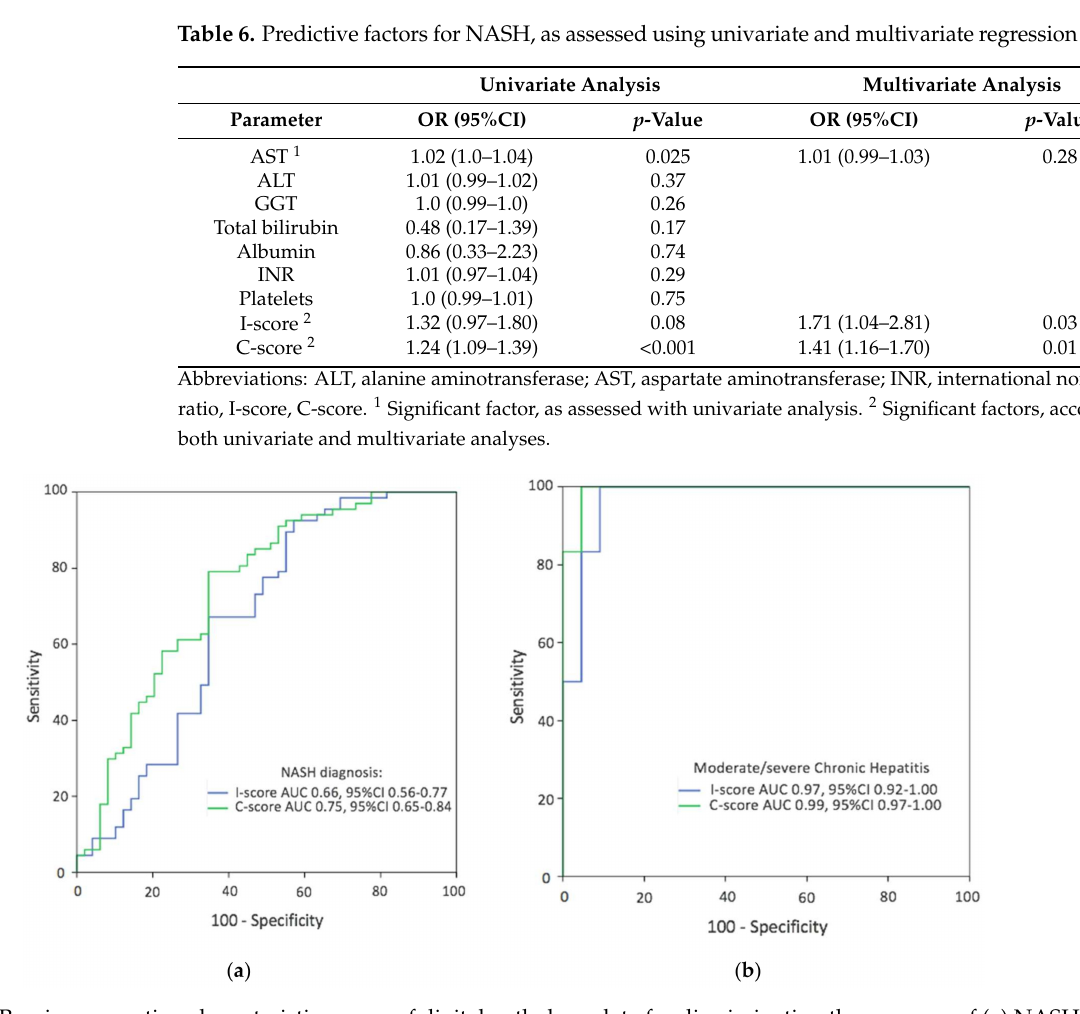
Figure 3. Receiver operating characteristic curves of digital pathology data for discriminating the presence of ( a ) NASH in NAFLD population, and ( b ) moderate/severe inflammation in chronic hepatitis cases. The blue line corresponds to I-score (%CD45+), and the green line corresponds to C-score (clusters proportion).